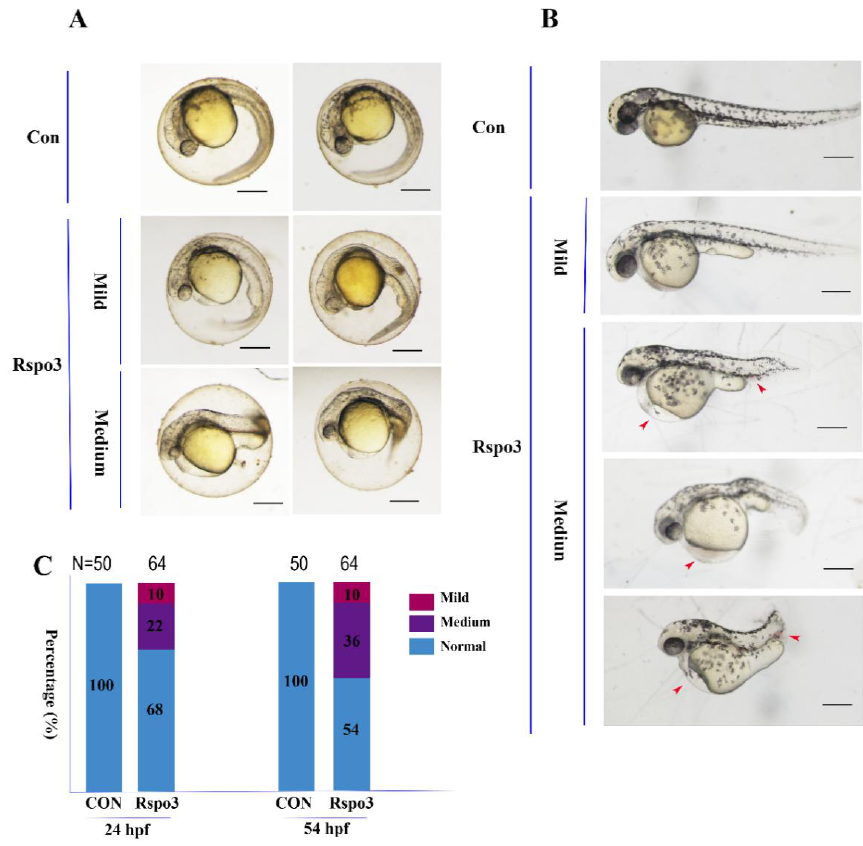
Figure 4. Overexpression of C. semilaevis Rspo3 affects Danio rerio embryo development. An amount of 1000 pg/embryo of C. semilaevis Rspo3 mRNA was injected into AB strain D. rerio embryos at 1–4 cell stages. All embryos are shown with anterior to the left. Scale bar = 200 μm. ( A ) Classification of phenotypes at 24 h post-fertilization (hpf); ( B ) Classification of phenotypes at 54 hpf. The red arrowheads indicate ecchymosis; ( C ) The percentages of embryos in each category as shown in ( A ) and ( B ); N is the number of total samples analyzed in each group.